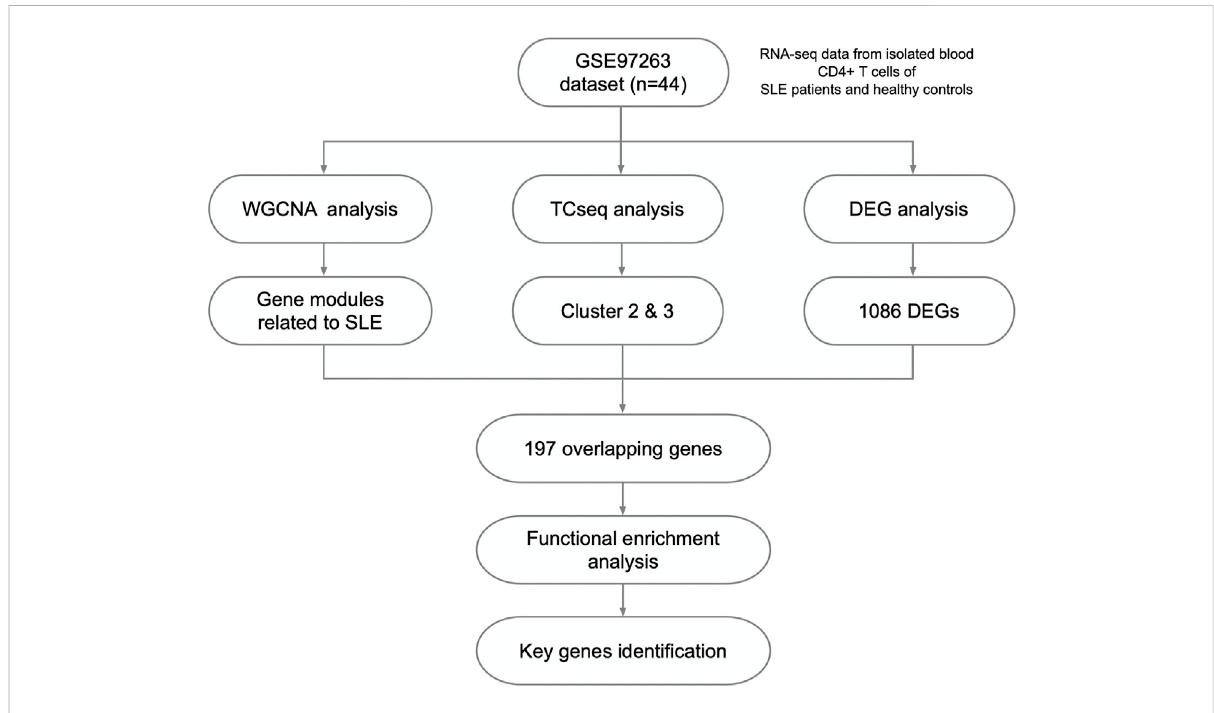
FIGURE 1 Study design and the work fl ow of this